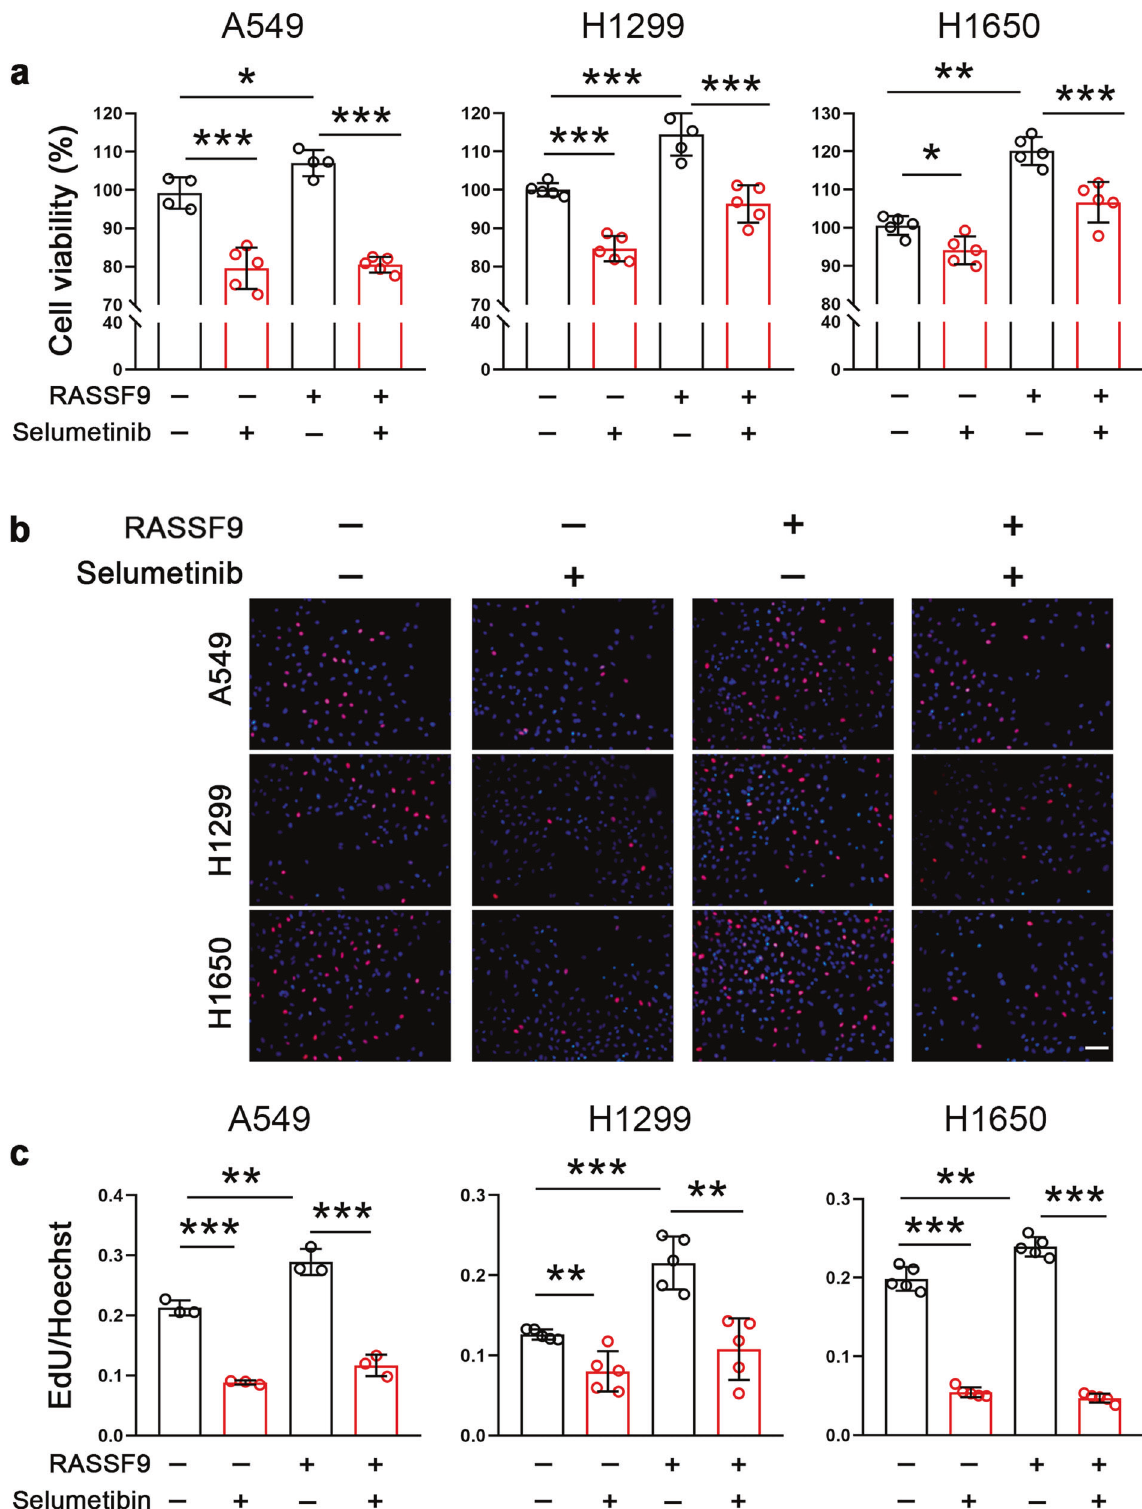
Fig. 5 MEK inhibition by selumetinib reduces RASSF9-induced NSCLC cell viability and proliferation. a Selumetinib reduces RASSF9- induced upregulation of cell viability. A549, H1299, and H1650 cells were transfected with the plasmid expressing Rassf9 . Twelve hours post- transfection, cells were treated with 10 μ M of selumetinib for additional 24 h and then subjected for cell viability assay by the method of MTT. b Selumetinib decreases RASSF9-induced EdU incorporation. Cell treatments were described in ( a ). Scale bar = 500 μ m. c Quantitative analysis for EdU incorporation. Data are presented as means ± SD (error bars). * P < 0.05, ** P < 0.01, and *** P < 0.001. One-way ANOVA